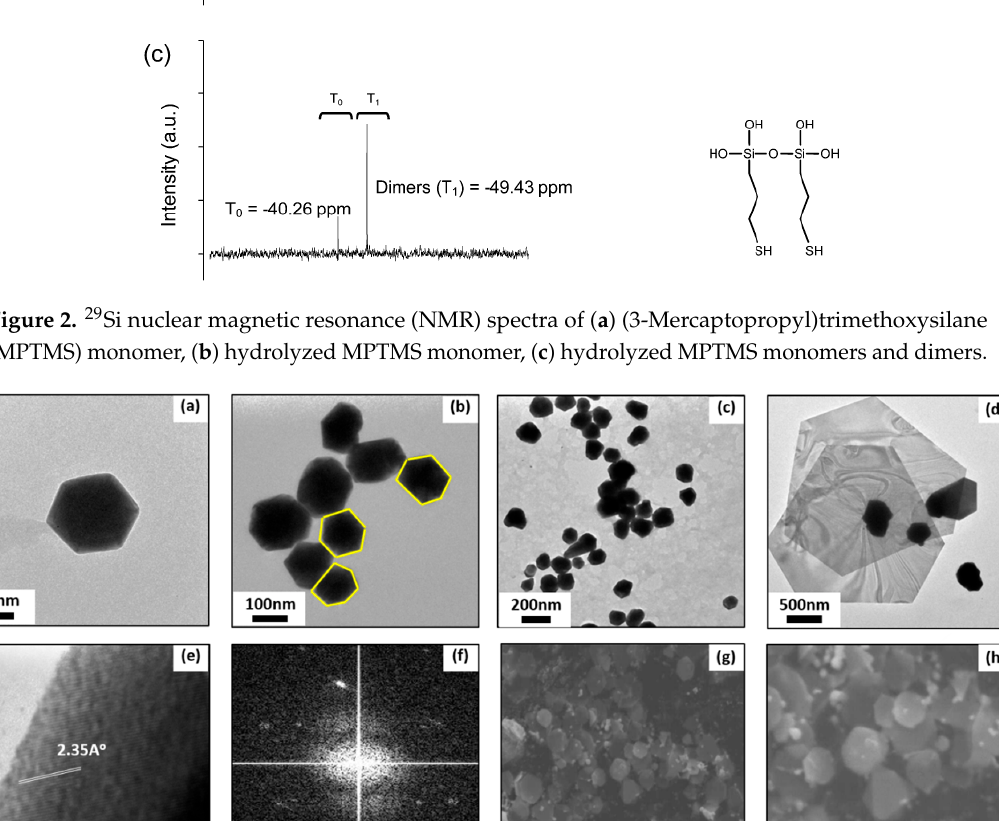
Figure 2. 29 Si nuclear magnetic resonance (NMR) spectra of ( a ) (3-Mercaptopropyl)trimethoxysilane (MPTMS) monomer, ( b ) hydrolyzed MPTMS monomer, ( c ) hydrolyzed MPTMS monomers and dimers.